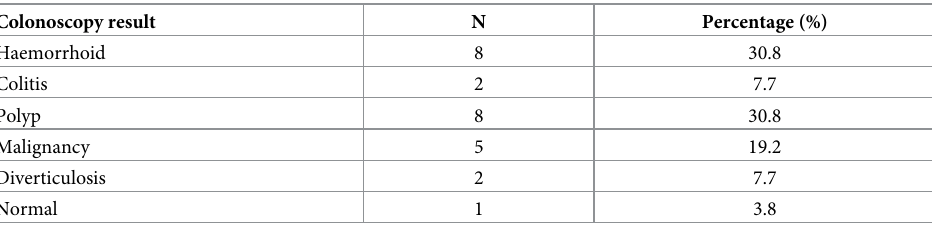
Table 4. Colonoscopy